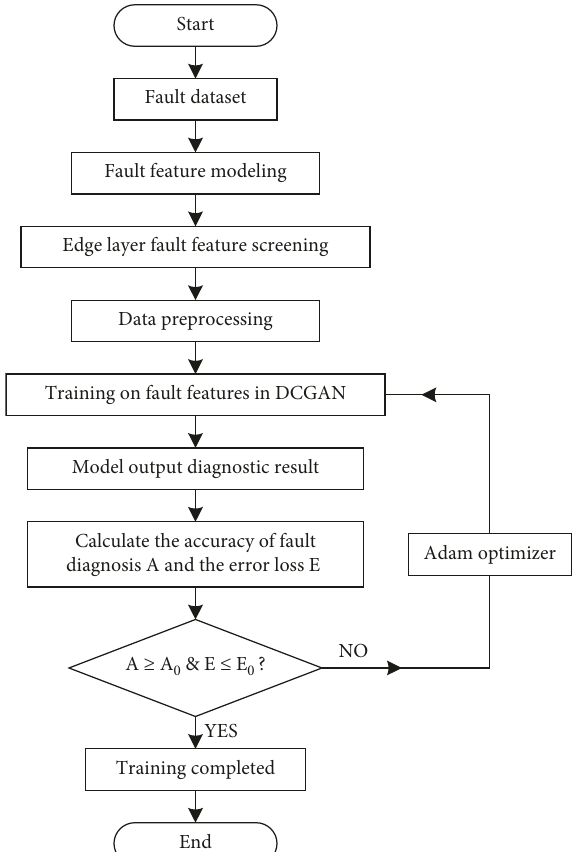
Figure 3: UHVDC fault diagnosis and decision-making flow